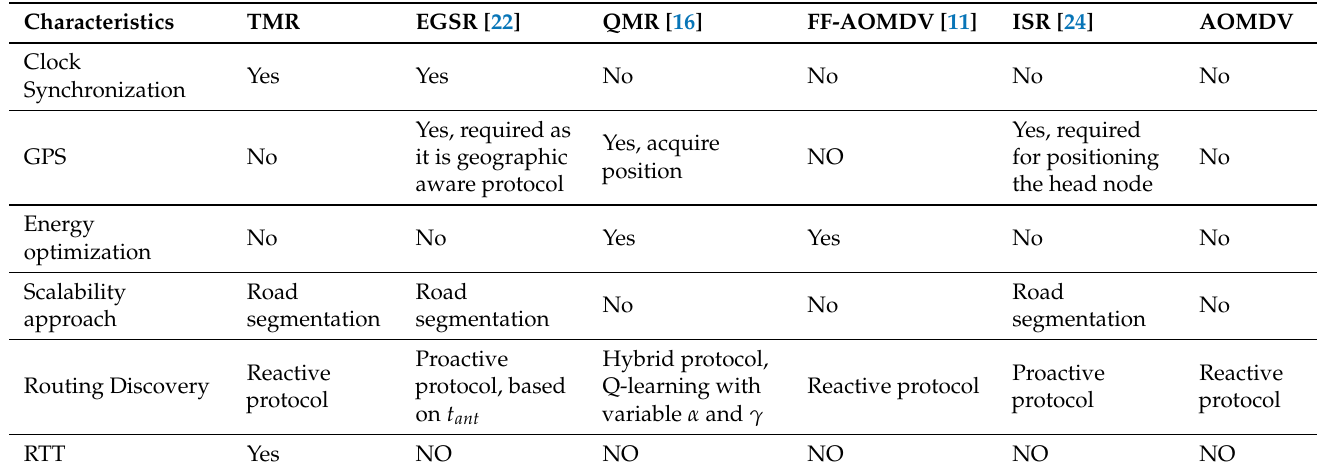
Table 8. Routing protocol characteristics comparison.